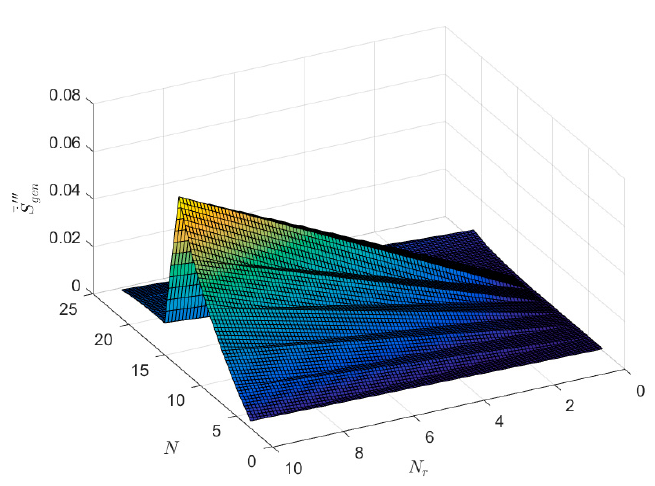
Figure 11. Dimensionless rate of total entropy generation as a function of heat source number and the heating ratio.